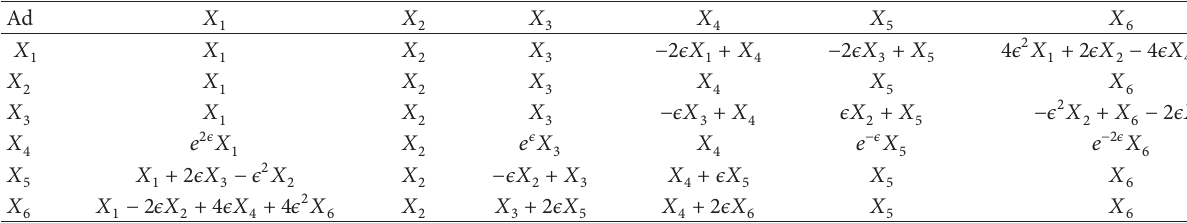
Table 2: Adjoint representation for the base vectors.